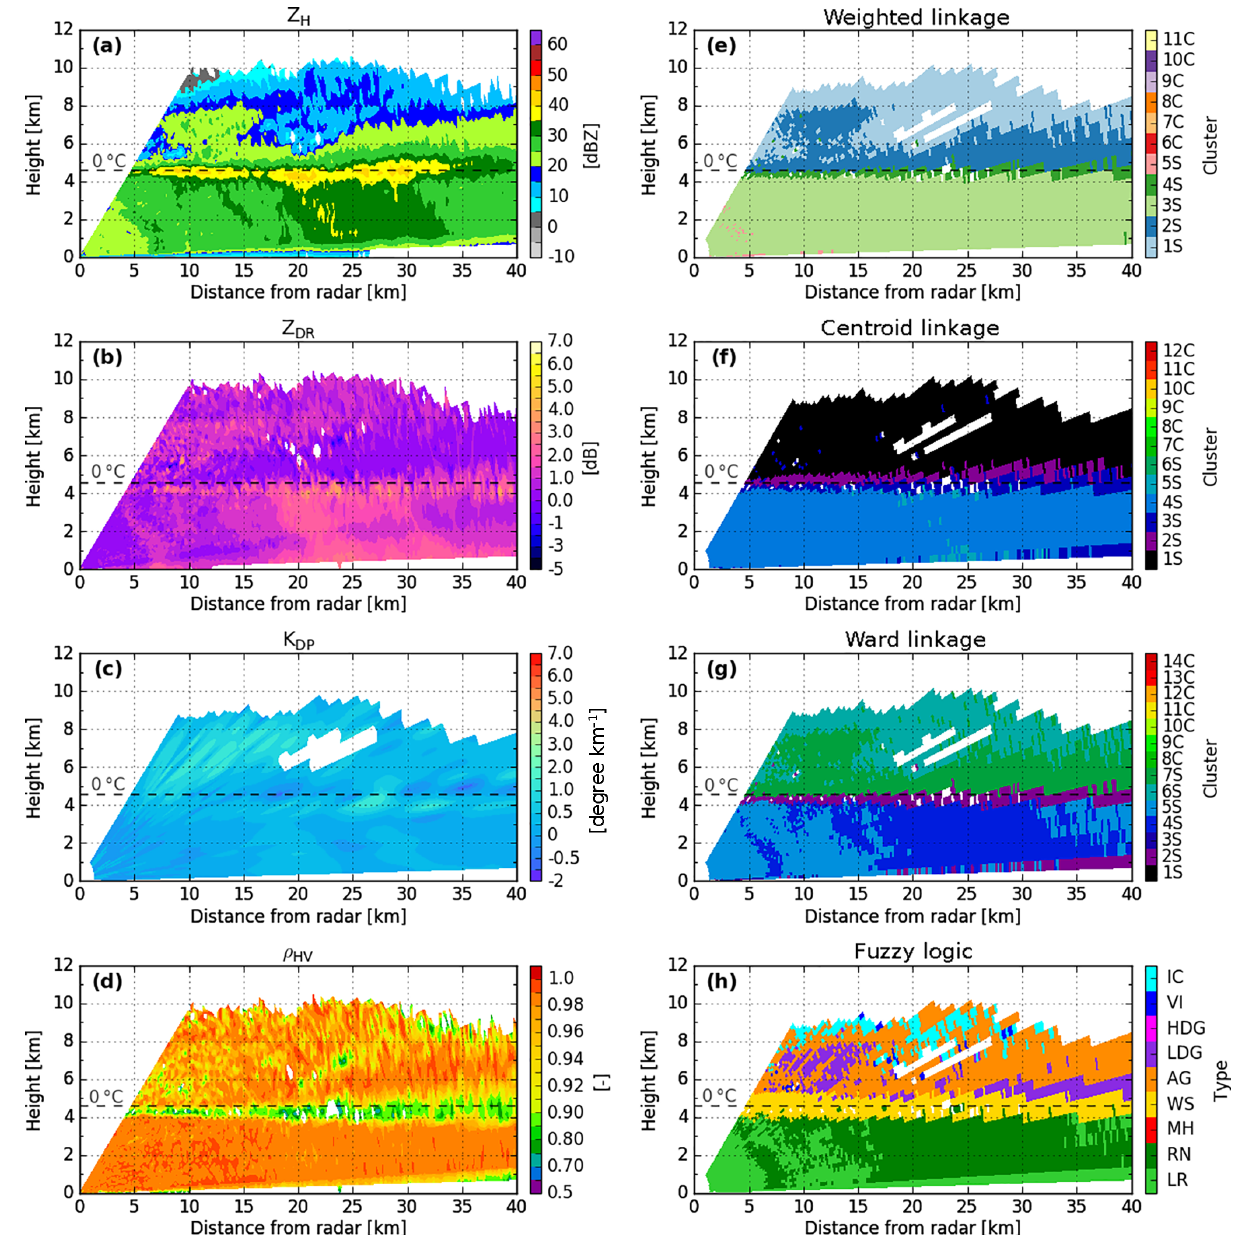
Figure 4. X-band DPOL radar observables and the corresponding retrieved hydrometeor classification outputs at 12:07UTC on 21 Febru- ary 2014, along the azimuth 290 ◦ . DPOL radar observables are shown in (a) Z H , (b) Z DR , (c) K DP , and (d) p HV . Comparisons of retrieved hydrometeors for clustering outputs based on (e) weighted, (f) centroid, and (g) Ward linkage rules and (h) fuzzy-logic scheme outputs. In (e) – (g) , each number corresponds to a different cluster. S stands for stratiform regimes, whereas C is for convective